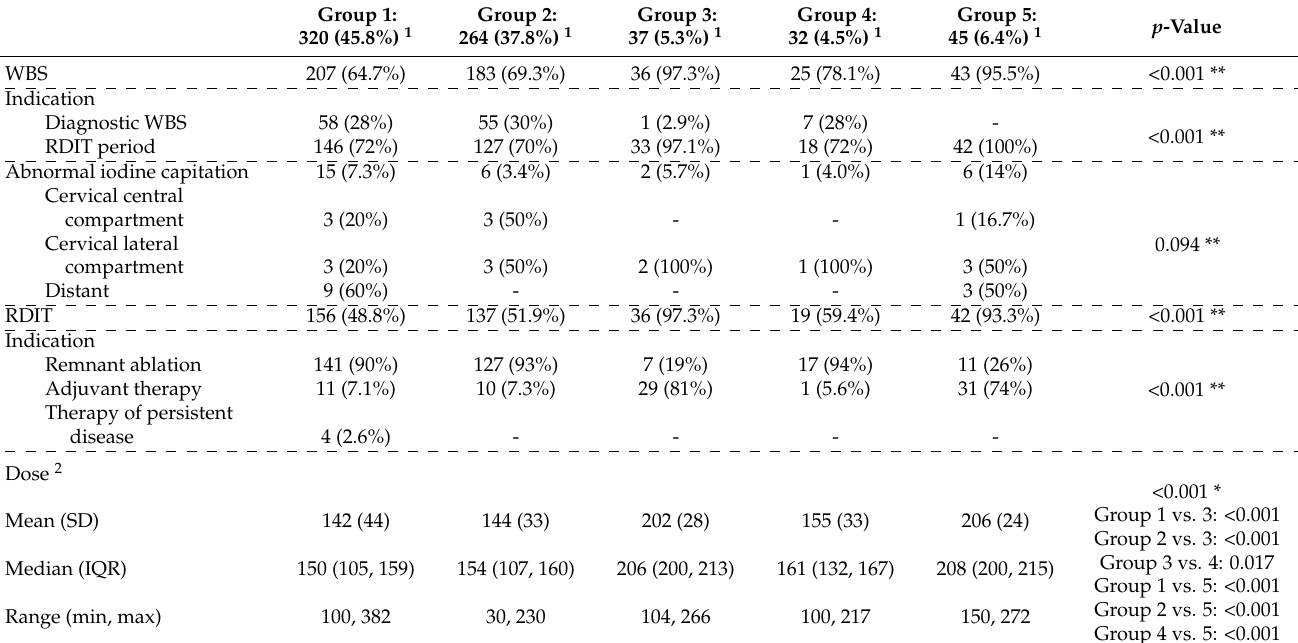
Table 2. Initial whole-body scintigraphy and initial radioiodine therapy